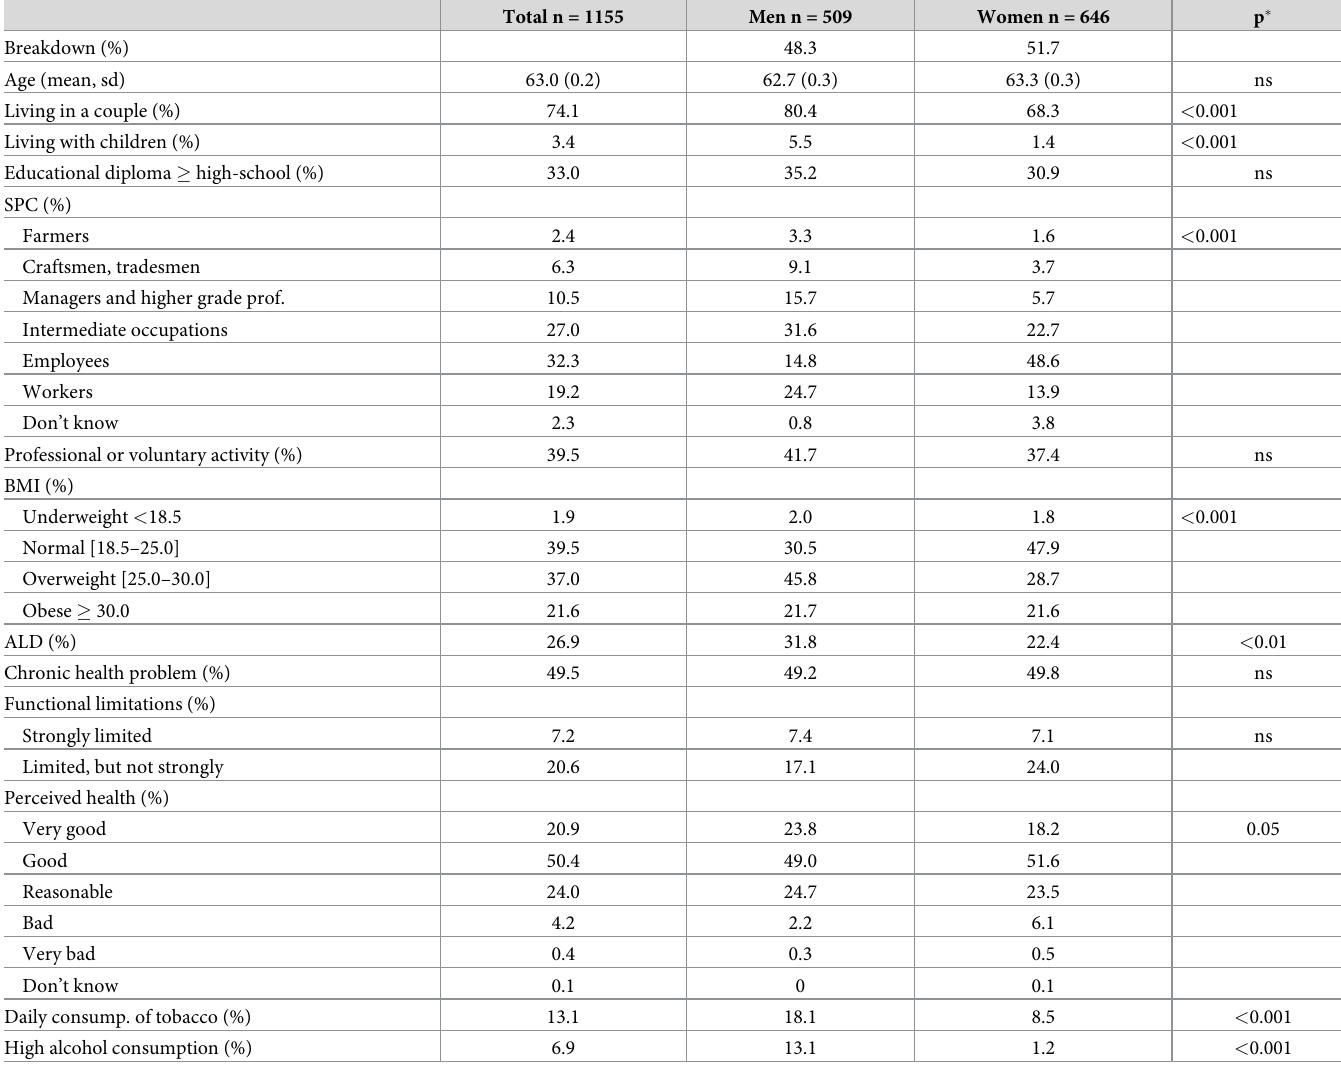
Table 3. Socio-demographic and health data of the study population (55–74 years)–Esteban study